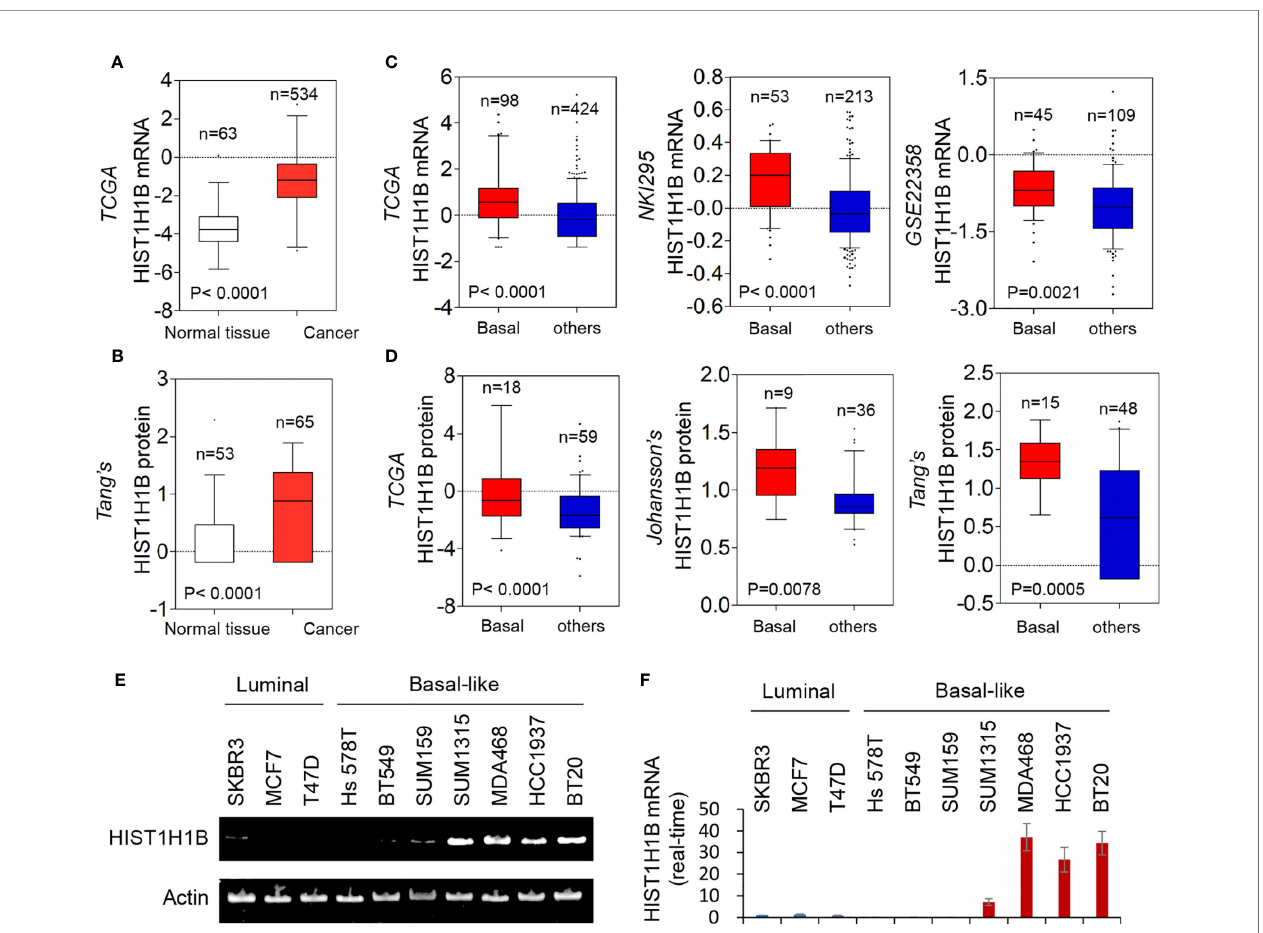
FIGURE 1 | HIST1H1B expression is upregulated in breast cancer. (A) Box-plots indicated HIST1H1B mRNA expression in breast cancer from TCGA. (B) Box-plots indicate HIST1H1B protein expression in different subtypes of breast cancer from the Tang's dataset. (C) Box-plots indicated HIST1H1B mRNA expression in different subtypes of breast cancer from three datasets (NKI295, TCGA and GSE22358). (D) Box-plots indicated HIST1H1B protein expression in different subtypes of breast cancer from three datasets (TCGA, Johansson's and Tang's). (E, F) Expression of HIST1H1B mRNA was analyzed by either quantitative real-time PCR (E) or semi quantitative RT-PCR (F) in a representative panel of breast cancer cell